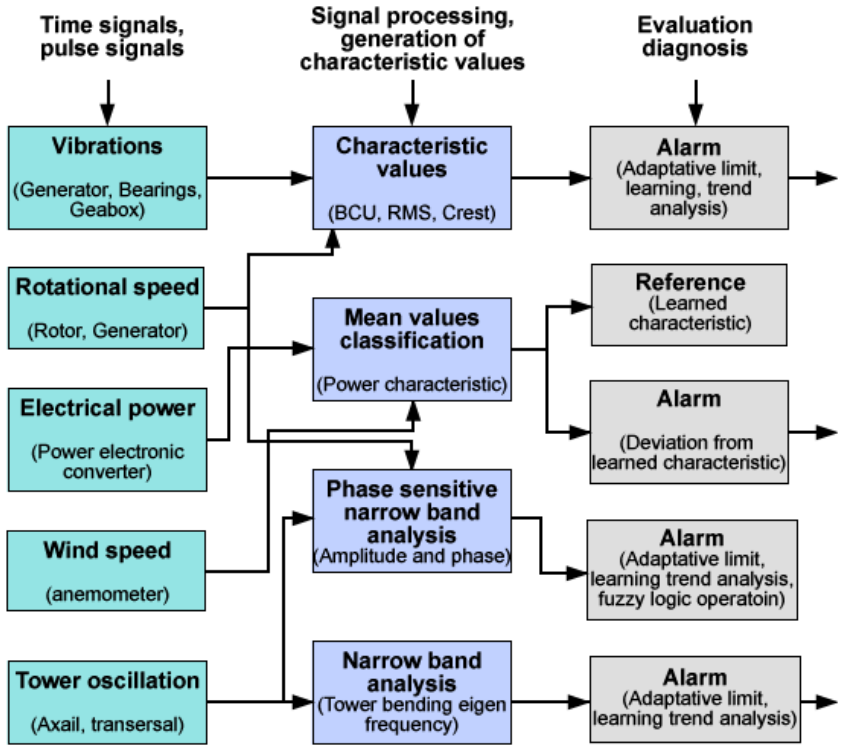
Figure 9. Function model for monitoring of a wind-energy conversion system (WECS) [53]. BCU: boundary controlling unstable; and RMS: root mean square. Reprinted/Reproduced with permission from [53]. Copyright 2008, Blekinge Institute of